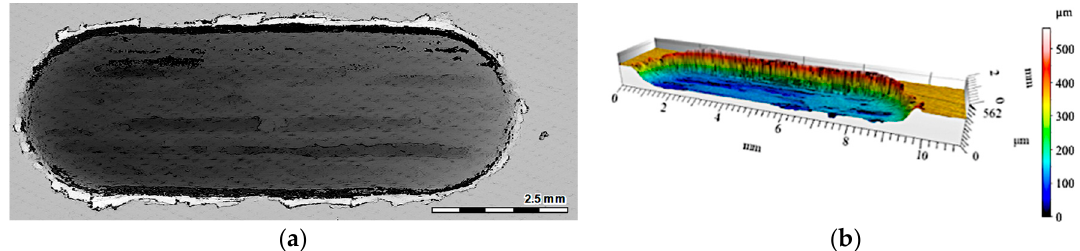
Figure 9. View of a wear trace in an un-reinforced area (AlSi7 matrix marked with blue line on Figure 8a) after dry sliding condition (Figure 8b): ( a ) Digital image; ( b ) Cross-section using a 3D view.